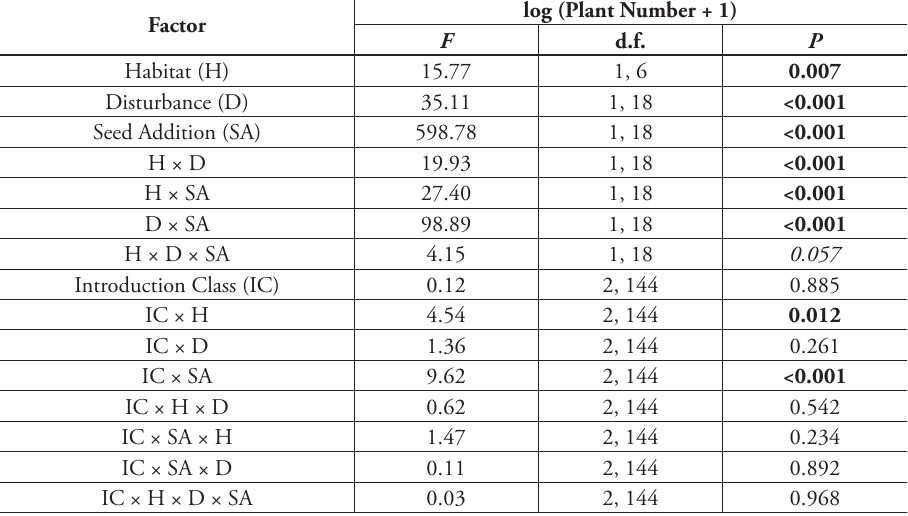
Table 1. General linear mixed model analysis describing the influence of habitat, disturbance, seed ad- dition, plant introduction class, and all possible interactions of these fixed factors on the log-transformed individual counts of plots established in Pacific Northwest steppe and forest communities. Significant differences at a Type I Error = 0.05 are indicated in bold; marginally significant differences at Type I Error = 0.10 are indicated in